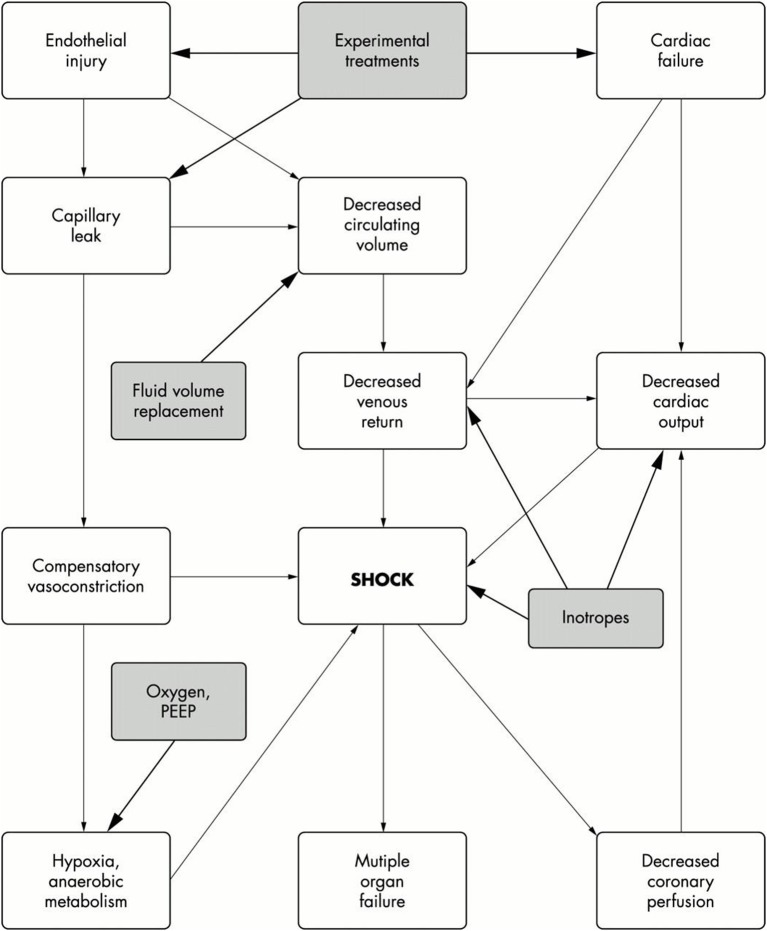
Pathophysiology of septic shock. Filled boxes are the treatment options. Taken from Welch and Nadel (15).